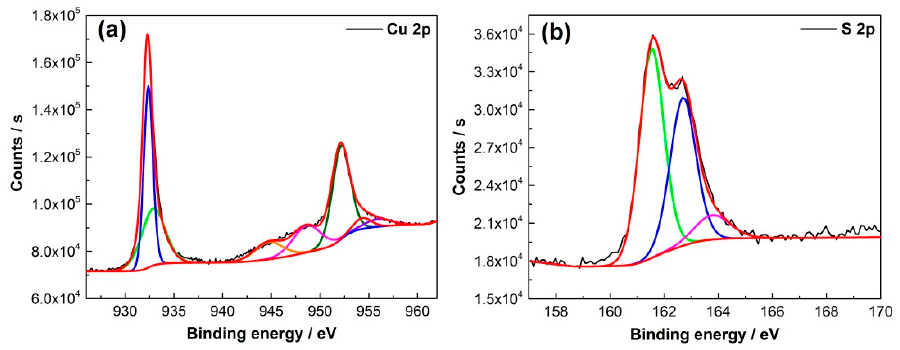
Figure 2. XPS patterns of CuS on Cu foam: ( a ) Cu2p and ( b )S2p.